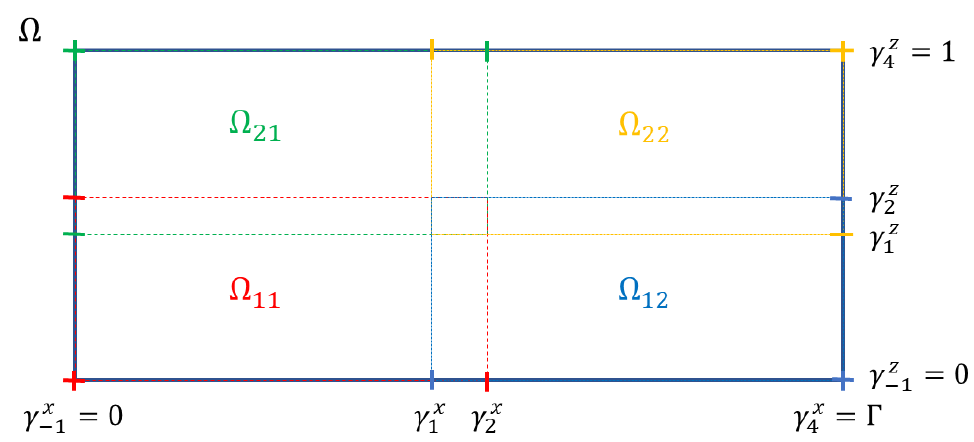
Figure 1. Example of domain Ω split in four subdomains with